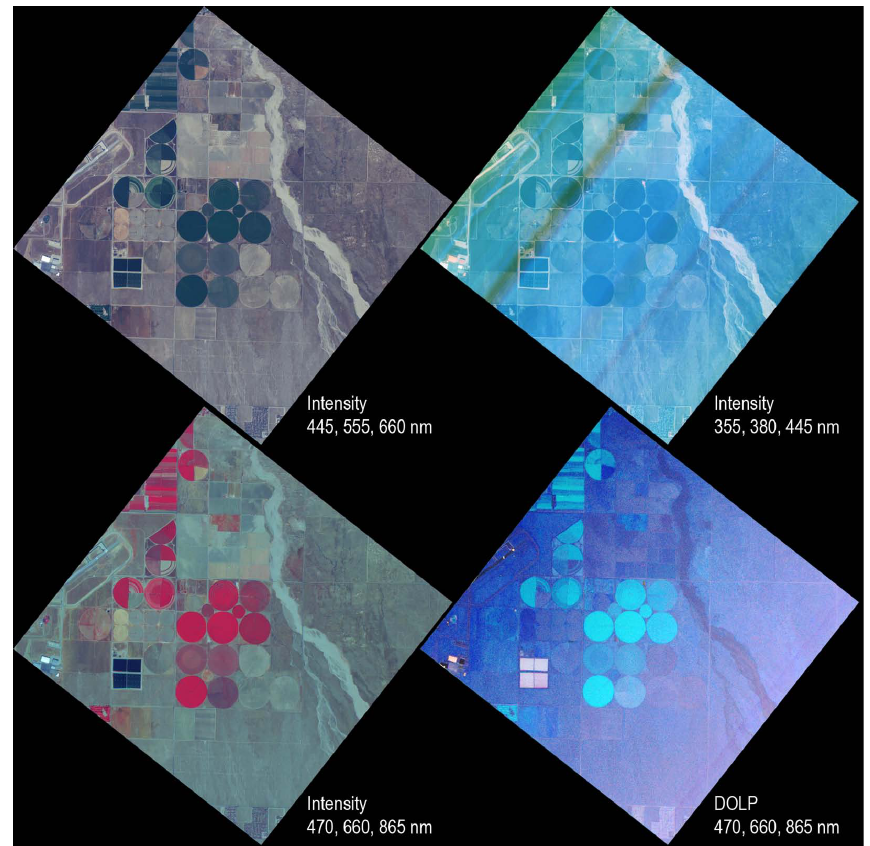
Fig. 3. Georectified imagery acquired during AirMSPI’s maiden flight on 7 October 2010. Top left panel: intensity at 445, 555, and 660nm displayed as blue, green, and red. Top right panel: intensity at 355, 380, and 445nm displayed as blue, green, and red. Bottom left panel: intensity at 470, 660, and 865nm displayed as blue, green, and red. Bottom right panel: DOLP in the same spectral bands. Flight direction is from upper right to lower left. The darker, discolored stripes in the top right image are due to defects in the spectral filters. Improved calibration of these pixels is under